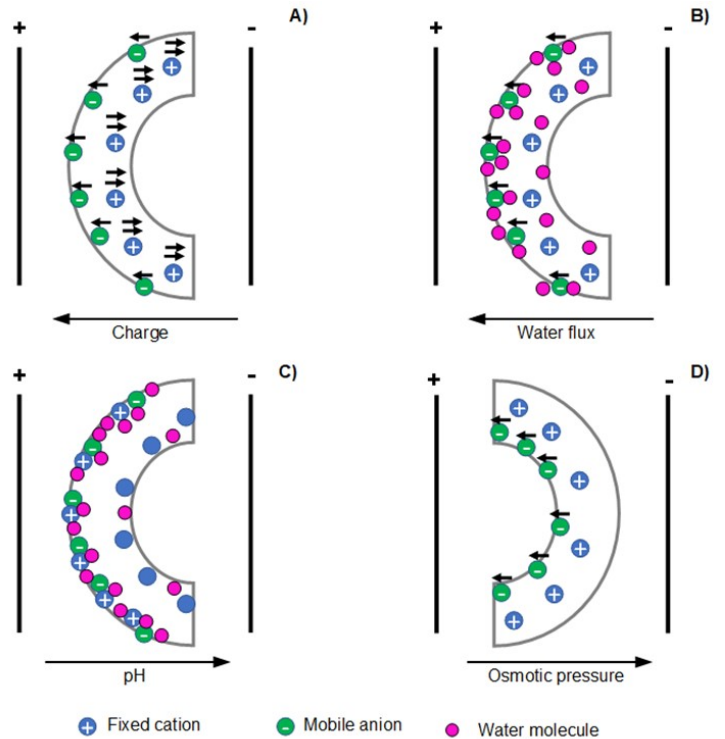
Figure 4. Representation of electro-assisted mechanical displacement mechanisms for a poly- cationic actuator. Coulomb ( A ), electroosmosis ( B ), electrochemical ( C ) and enrichment/depletion ( D ) mechanism.